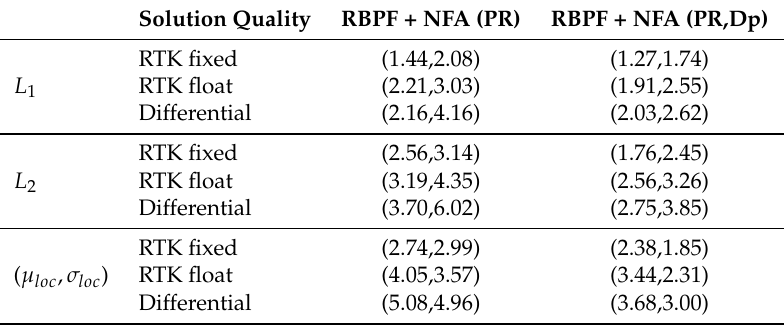
Table 3. Proposed method localization error (in m) on (east, north) coordinates, Norm 1 and Norm 2 of error, error mean and standard deviation versus the quality of RTK solution used as the ground